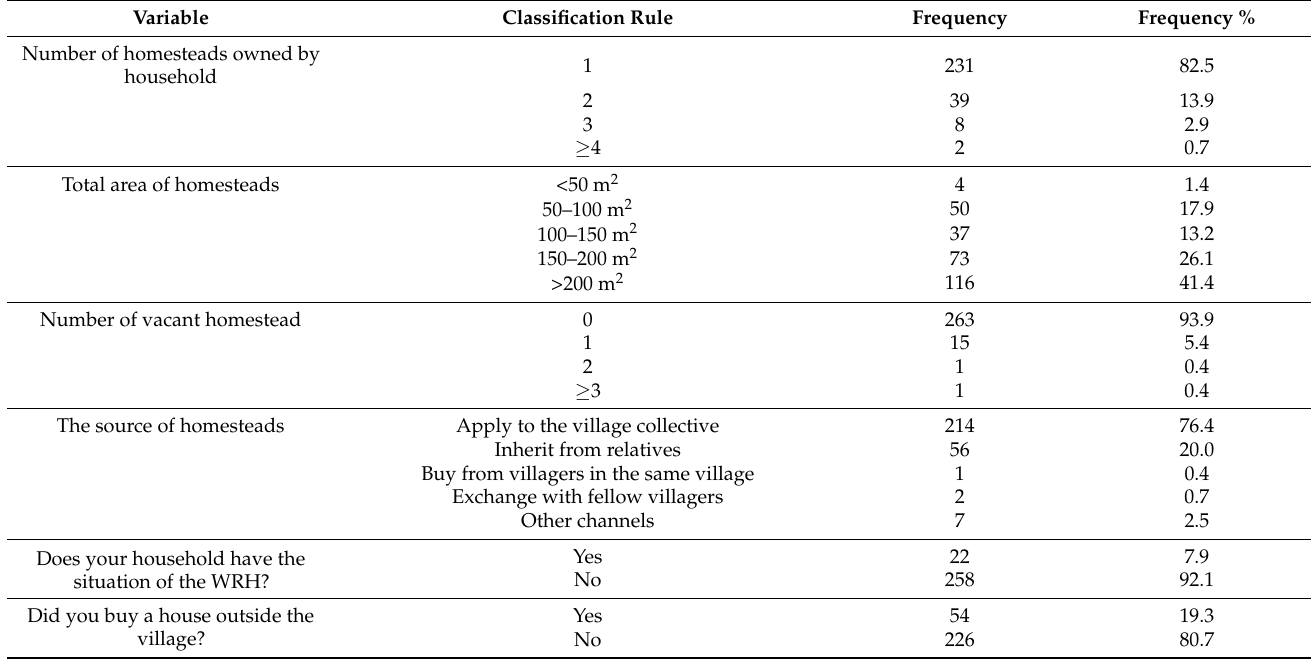
Table 4. Descriptive statistics of homesteads ( n = 280).